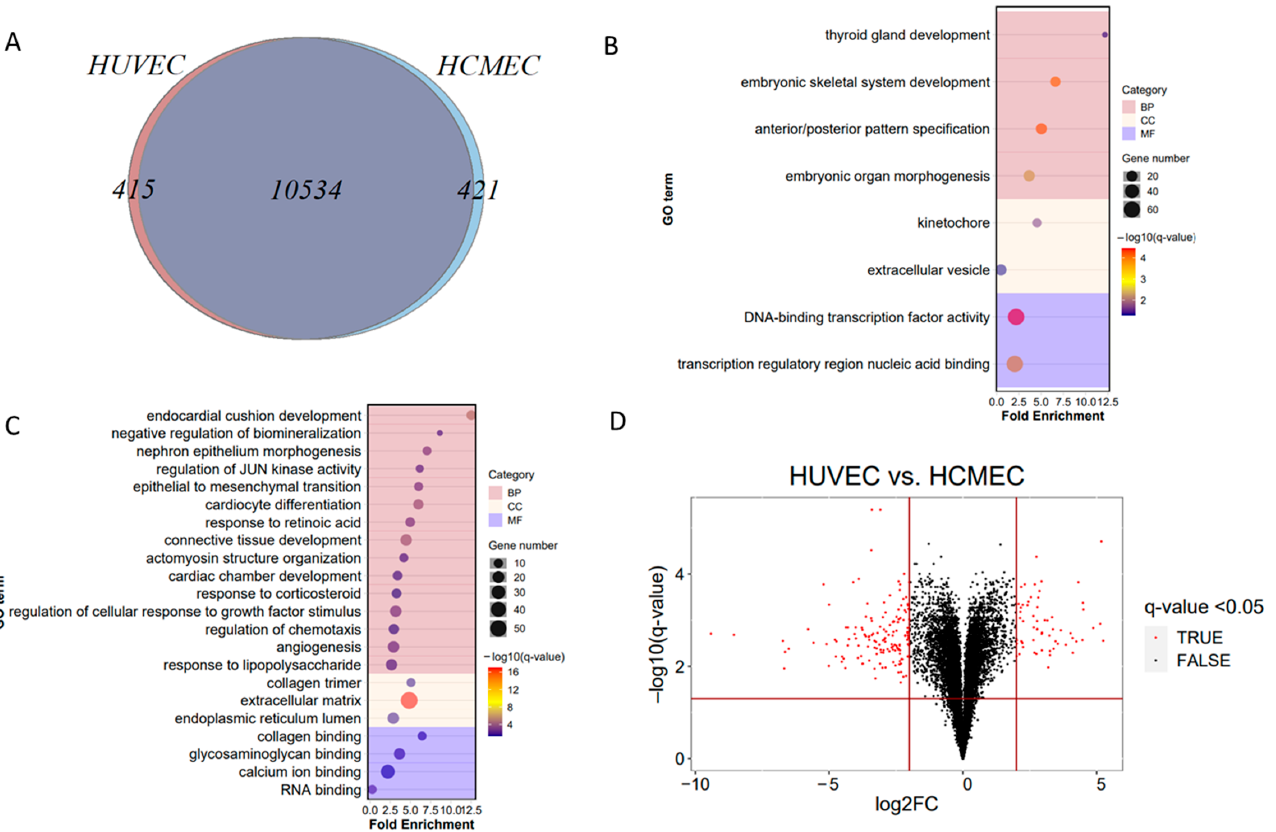
Figure 4. Endothelial cell model comparison. ( A ) Venn diagram of differentially expressed genes in Human Umbilical Vein Endothelial Cells (HUVEC) versus Human Cardiac Microvascular Endothelial Cells (HCMEC) ( B ) Gene Ontology (GO) term enrichment analysis of 415 HUVEC-specific genes. Number of genes per GO term and fold enrichment are given by bubble size and on the x -axis, respectively; the pink categories represents significantly regulated biological processes (BP), the light-yellow categories cellular components (CC), the purple categories blue molecular function (MF), as identified by Panther Gene Ontology Enrichment Analysis (FDR Q-value < 0.05) ( C ) 421 HCMEC-specific genes ( D ) Volcano plot of differentially regulated transcripts in HUVEC vs. HCMEC (FDR Q-value < 0.05, abs(log2FC) > 2), 148 genes were less and 60 were more abundant in HUVEC.